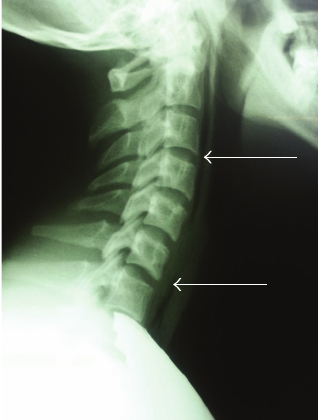
Figure 1: Neck X-ray, lateral view; free air is indicated by arrows.